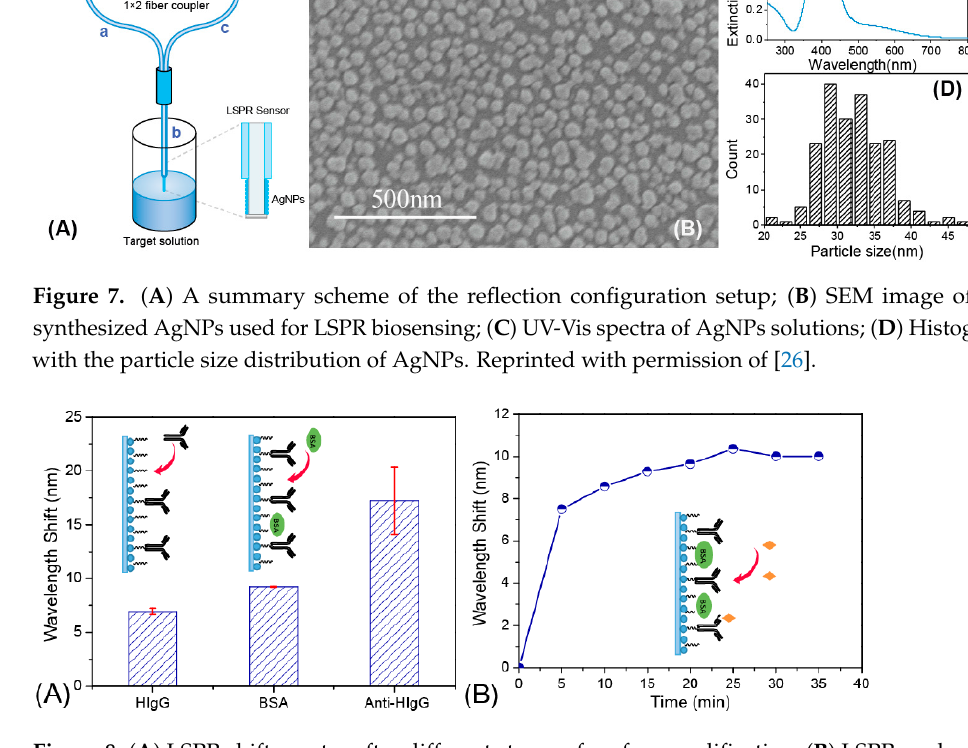
Figure 8. ( A ) LSPR shift spectra after different stages of surface modification; ( B ) LSPR peak wave- length changes during the process of anti-human IgG immobilization on the Ag NP-based sensor surface. Reprinted with permission of [26].